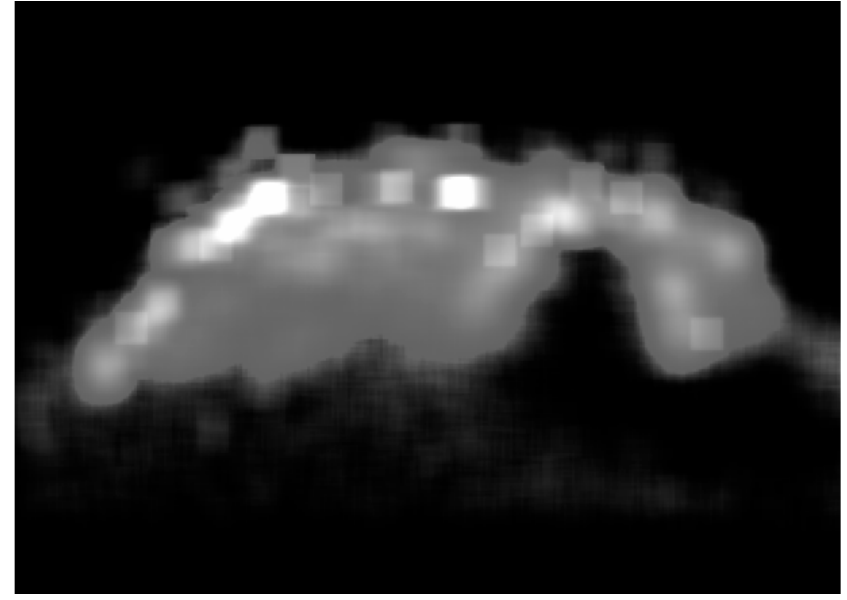
Figure 4. Two-dimensional distribution diagram.